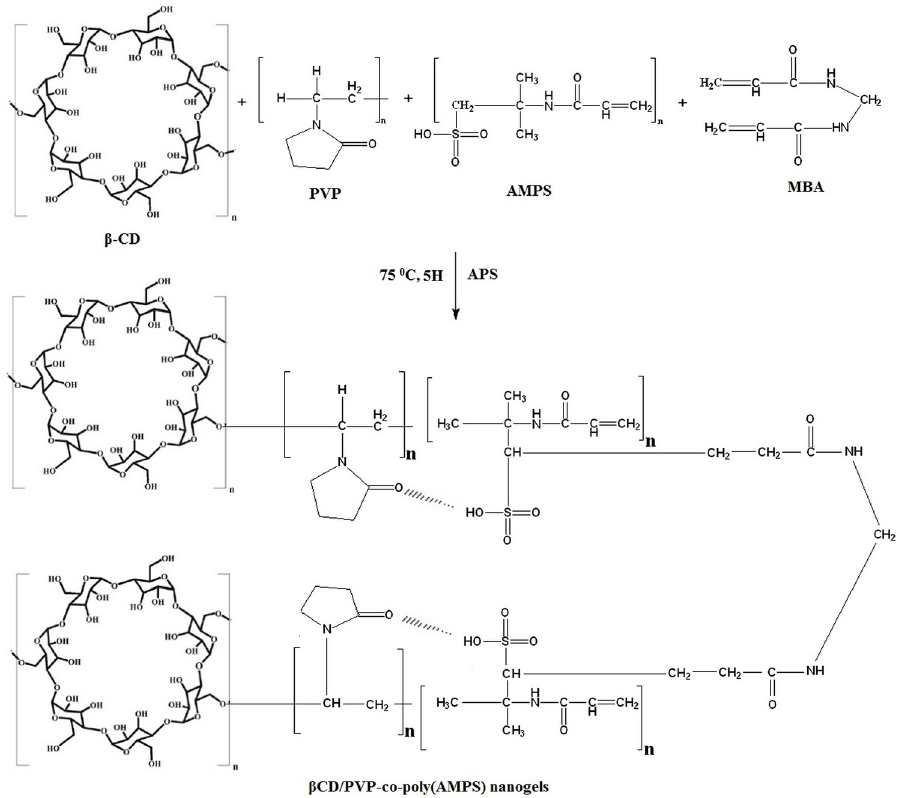
Fig 1. Schematic illustration of β CD/PVP-co-poly (AMPS) nanogels showing possible chemical crosslinking.